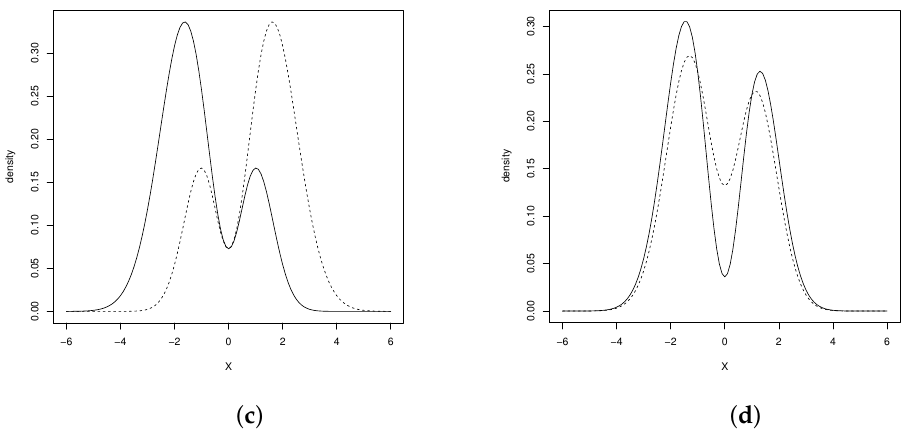
Figure 1. Distributions ( a ) BESN(0.8,0) (solid line), BESN(0.2,0) (dashed line); ( b ) BESN(0,10) (solid line), BESN(0,2) (dashed line); ( c ) BESN(0.05,10) (solid line), BESN(0.05,2) (dashed line); and ( d ) BESN(0.2,4) (solid line), BESN( − 0.2,4) (dashed